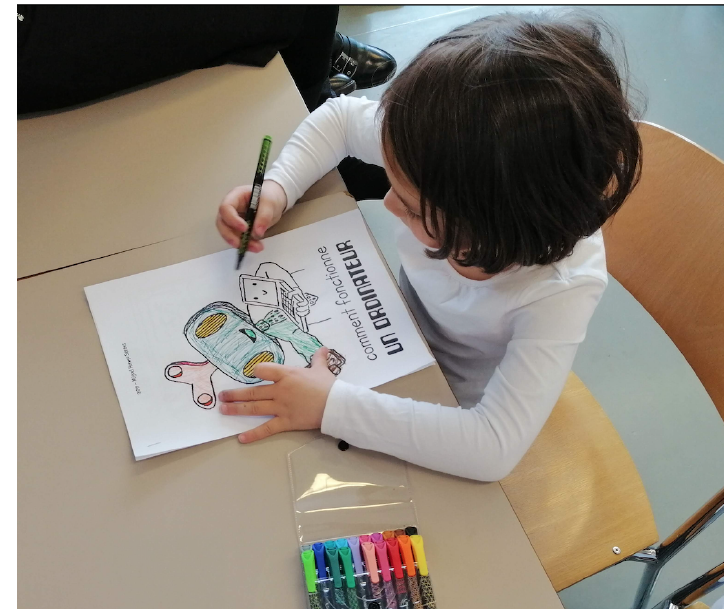
Figure 5. Colouring Book